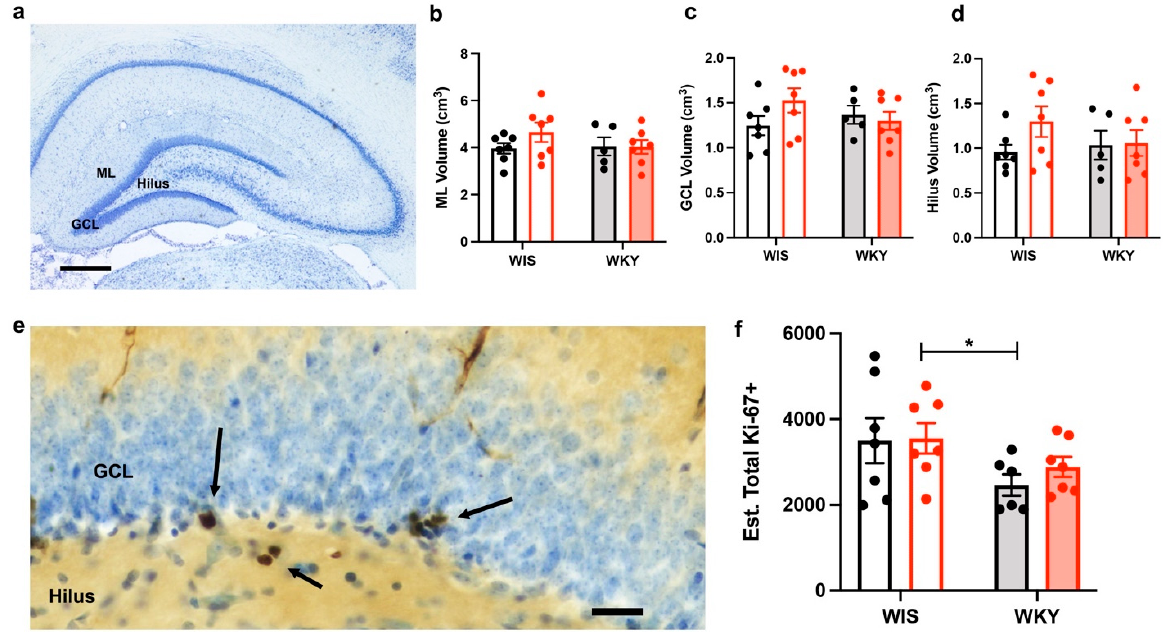
Figure 4. No dentate gyrus volume changes but fewer proliferative cells in WKY strain. ( a ) Cresyl violet stained sections were analyzed for volume of the molecular layer (ML), granule cell layer (GCL), and Hilus. No statistically significant findings were seen in the ML ( b ), GCL ( c ), or Hilus ( d ) between WIS (open bars), WKY (filled bars), or between the sham (black) or injured (red). ( e ) Ki-67 immunopositivity is illustrated in this example photomicrograph from a WIS sham animal. Ki-67+ nuclei are noted by brown diaminobenzidine (arrows). Sections were counterstained with Cresyl Violet. ( f ) Although there was no difference in Ki-67 immunopositivity three weeks after LFPI, there was an effect of strain, with WKY having fewer Ki-67+ cells. Scale bar in ( a ) = 500 µ m, in ( e ) = 25 µ m; * p <